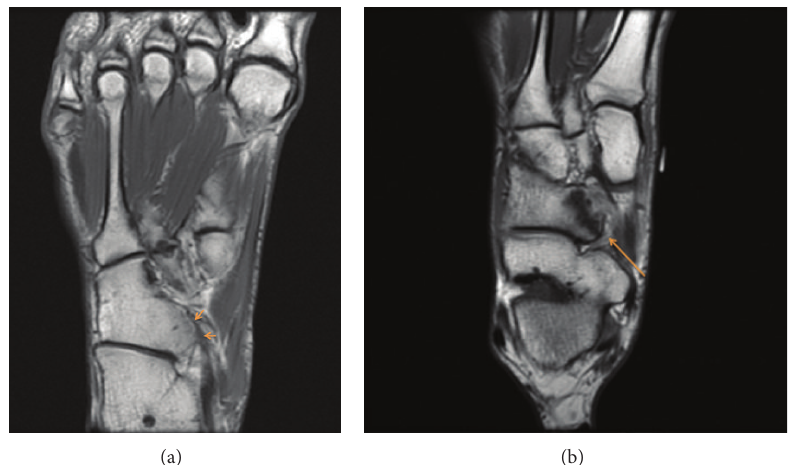
Figure 2: (a)-(b) Coronal T1 weighted unenhanced MR images of the right foot in a 17-year-old male show an elongated posterior medial process of the cuboid (arrows, (a)) that articulates abnormally with the plantar lateral aspect of the navicular (arrow, (b)), consistent with cuboid-navicular